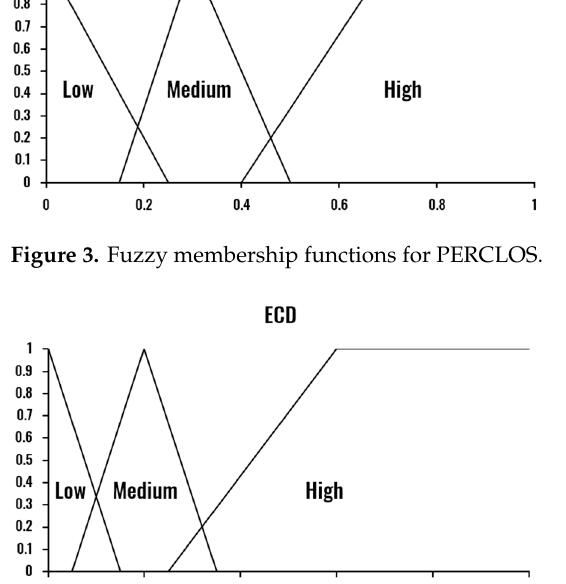
Figure 4. Fuzzy membership functions for eye closing duration (ECD).